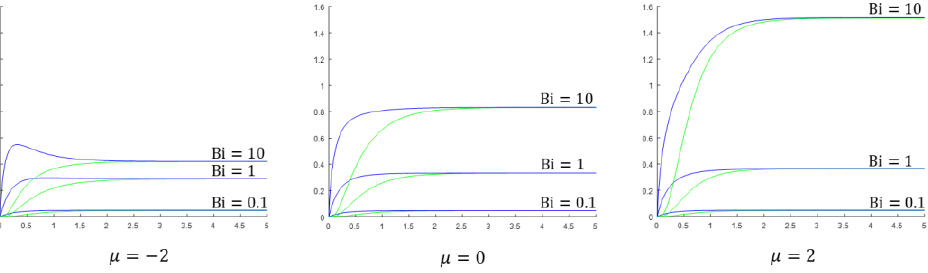
Figure 5. The dimensionless heat flux through the contact surface liquid–solid-body (blue) and through the right boundary (green) as a function of the time τ for τ a = τ c = 0.5 and three different Biot numbers. The thermal conductivity is g ( θ ) = e µθ , µ = − 2,0,2.